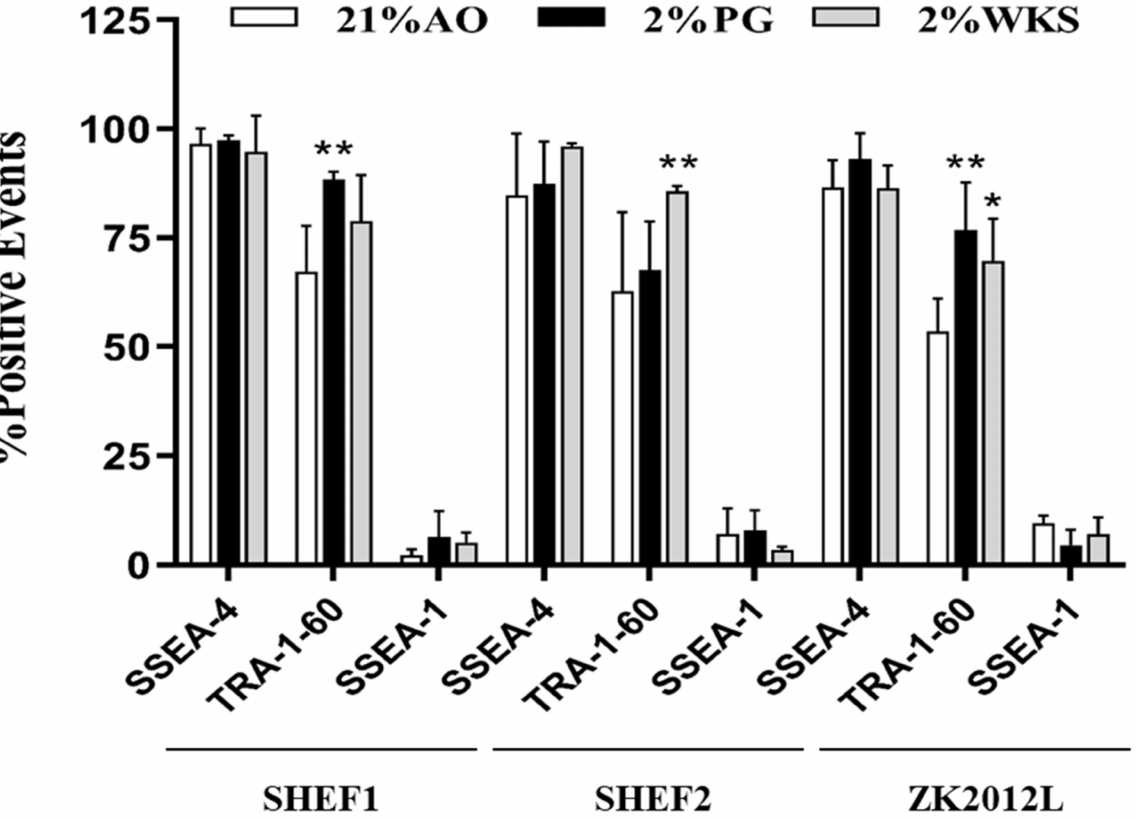
Figure 1. Immunophenotypic characterisation of PSCs. Flow cytometry-based evaluation of expres- sion of pluripotency markers. All PSCs were analysed for SSEA-4, TRA-1-60, SSEA-1 expression in both reduced oxygen (2% PG and 2% WKS) and 21% AO conditions. Y -axis indicates sample names and surface markers. The X -axis shows percentage of positive events. Data are presented as a mean ( n = 3), * p < 0.05, ** p < 0.01 vs. 21% AO, and error bar indicates standard deviation